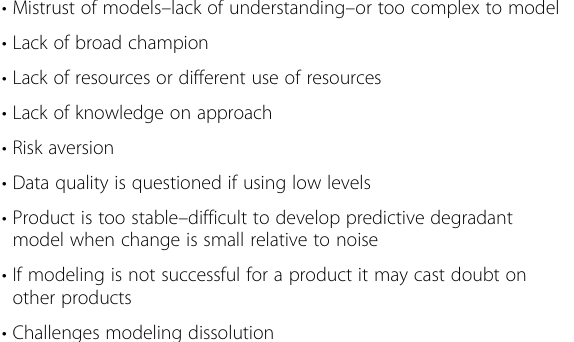
Table 1 Example of challenges encountered using predictive stability